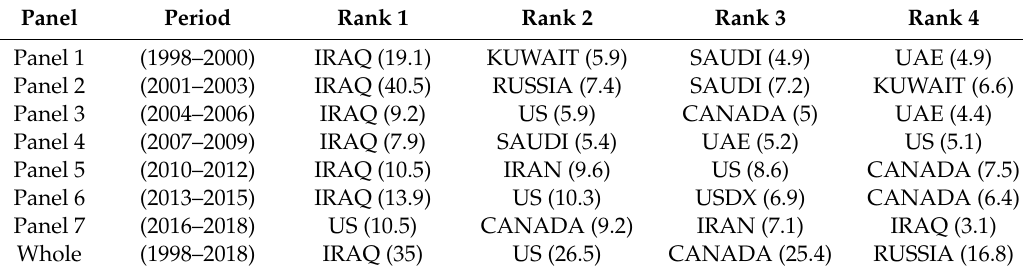
Table 4. Top four countries with the highest coefficients of variations for by panel.